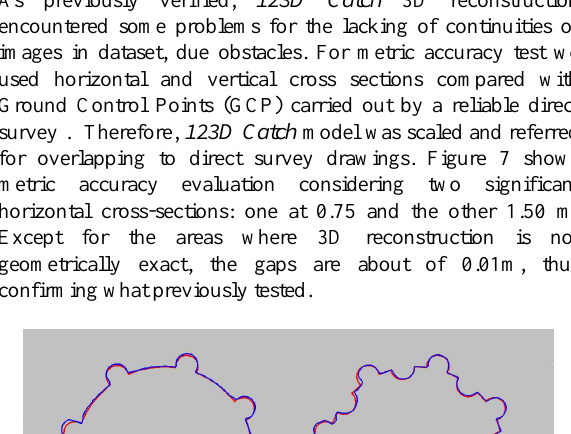
Figure 6: Auteri Chapel 123D Catch model, on the right smooth visualization